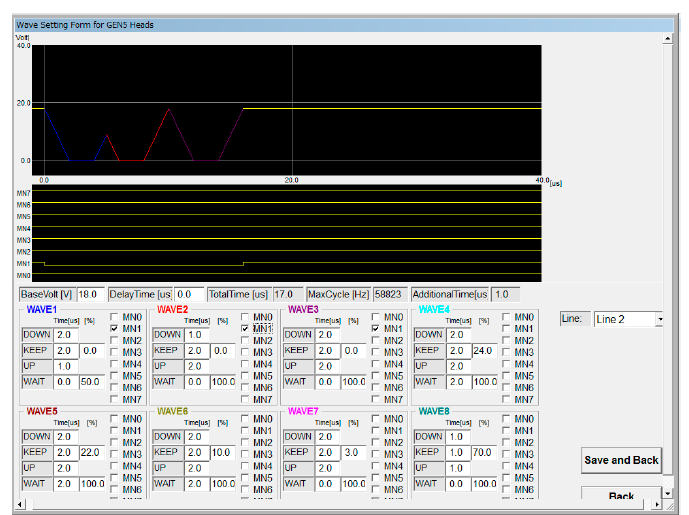
Figure 4. Waveform setting.